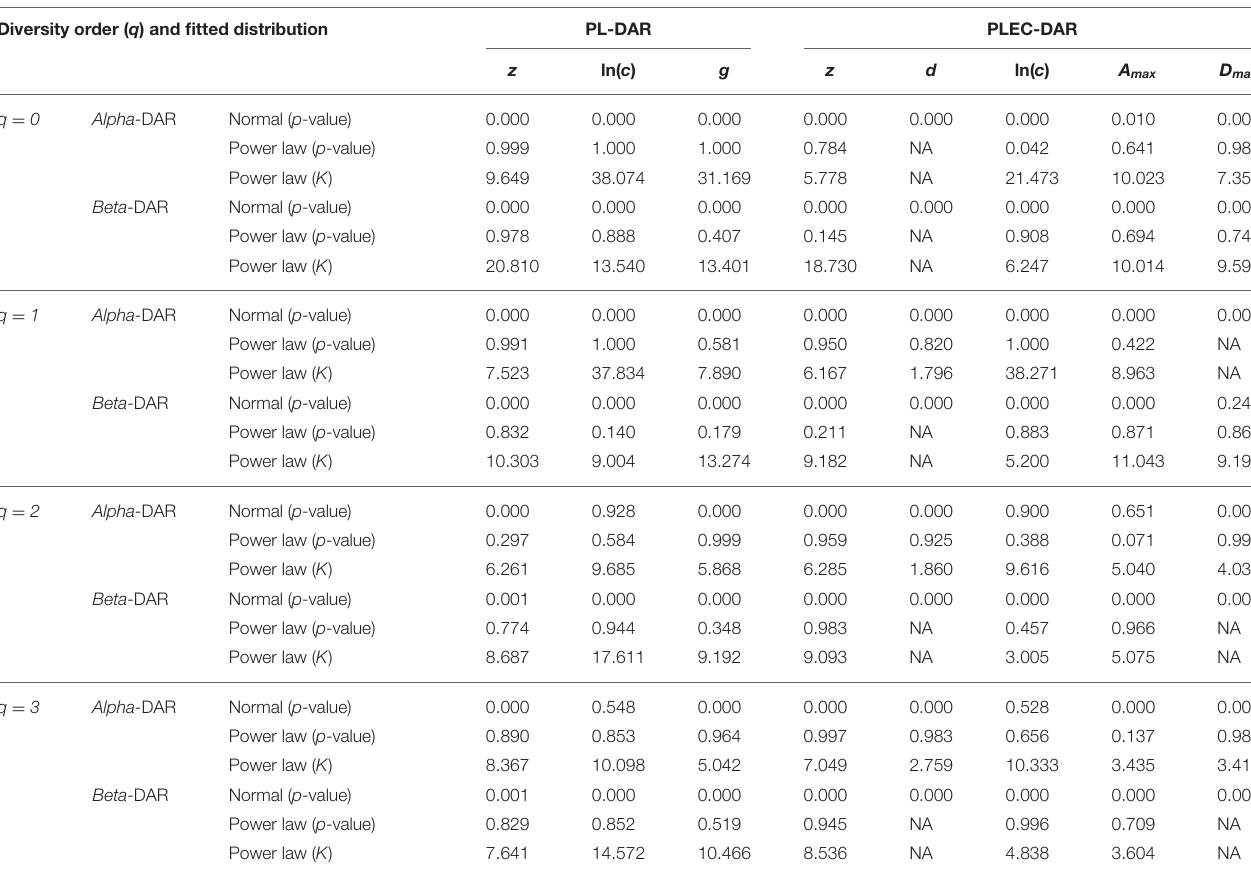
TABLE 4 | The distribution fitting results for the parameters of PL and PLEC models of the intra-subject-DAR. Diversity order ( q ) and fitted distribution